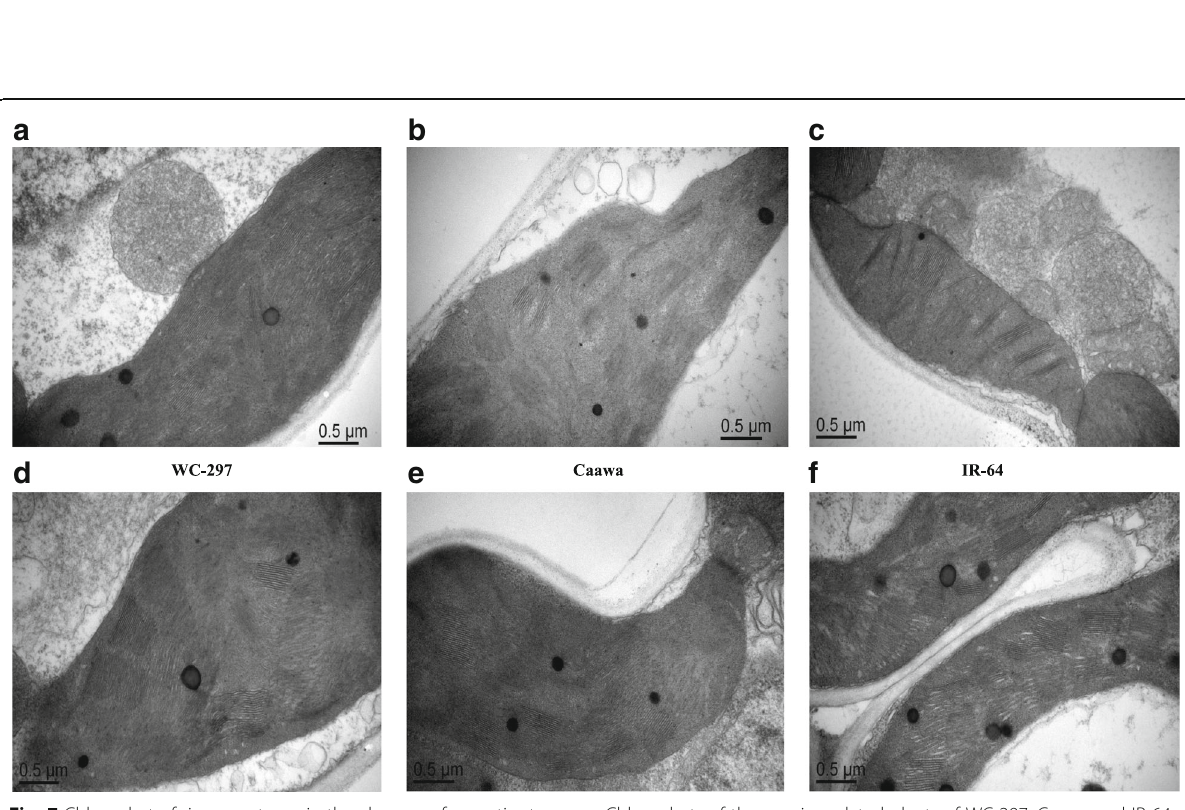
Fig. 7 Chloroplast of rice genotypes in the absence of osmotic stress. a-c Chloroplasts of the non-inoculated plants of WC-297, Caawa and IR-64, respectively. d-f Chloroplasts of the inoculated plants of WC-297, Caawa and IR-64, respectively. Grana in chloroplasts are better organized in rice plants inoculated with P. indica